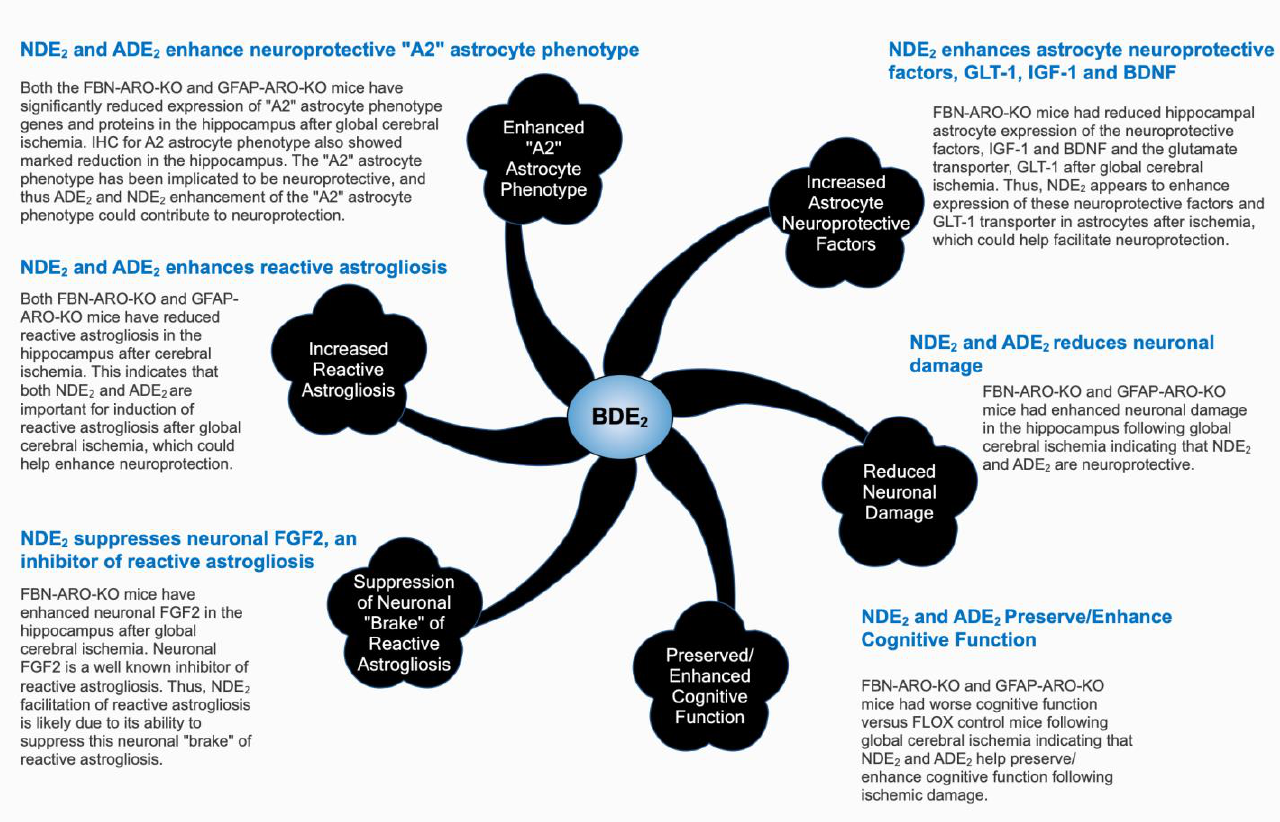
Figure 2. Proposed Mechanisms Underlying Astrocyte-Derived Estrogen (ADE 2 ) and Neuron-Derived Estrogen (NDE 2 ) Neuroprotection in Global Cerebral Ischemia. See text for description.